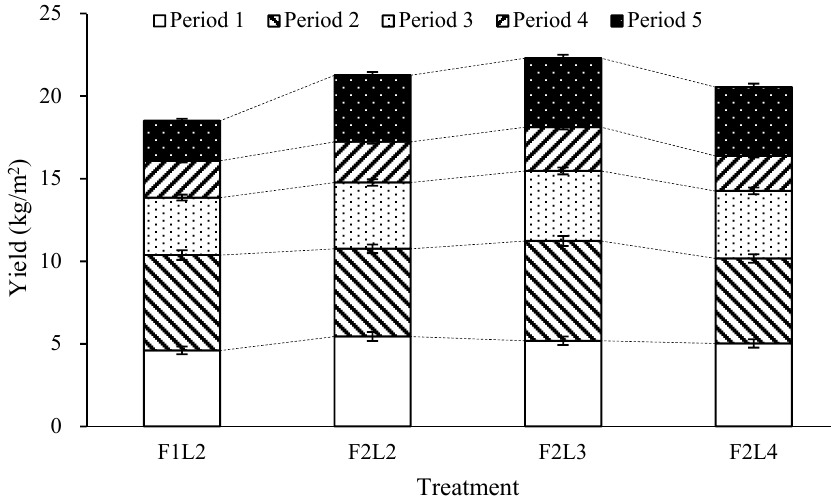
Figure 4. Effects of lateral leaves and flowers on yield by growth period in winter-planted and summer-cultivated paprika ‘Redwing RZ’. Each growth period was divided into 8 weeks after treatment. Error bars indicate the standard deviation of sample means ( n = 144).